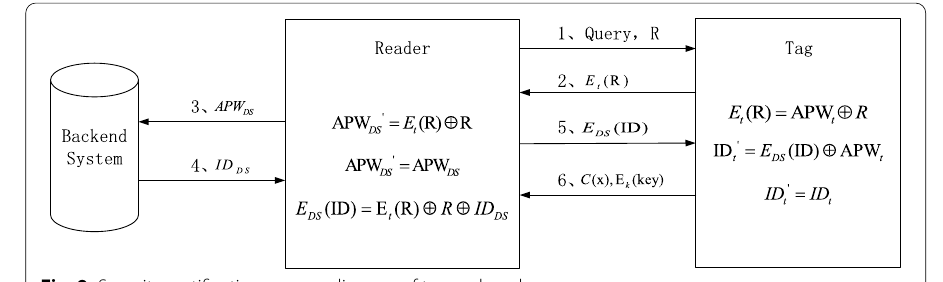
Fig. 9 Security certification process diagram of tag and